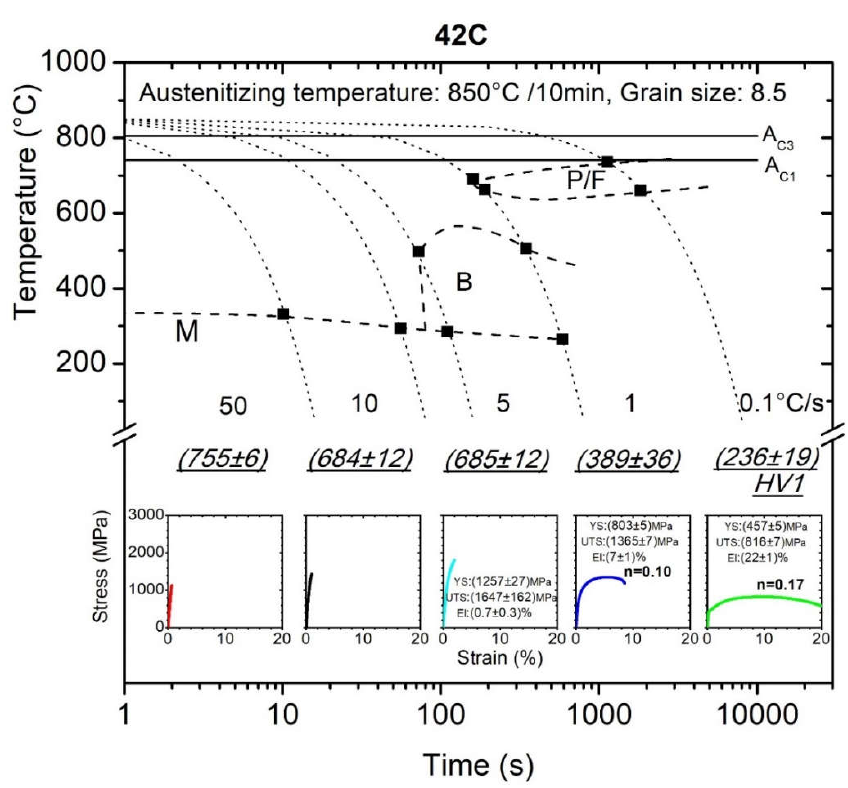
Figure 3. CCT diagram for conventionally manufactured 42C (P/F: perlite + ferrite, B: bainite, M: martensite).